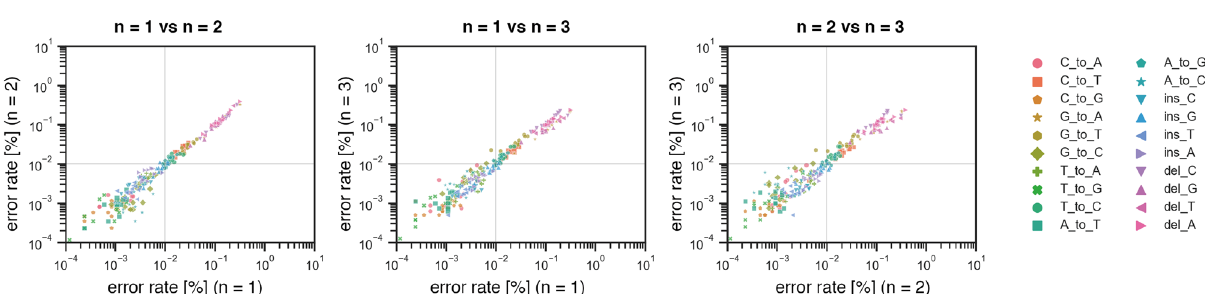
Figure 2. Synthetic error quantification of chemically synthesized oligonucleotides.